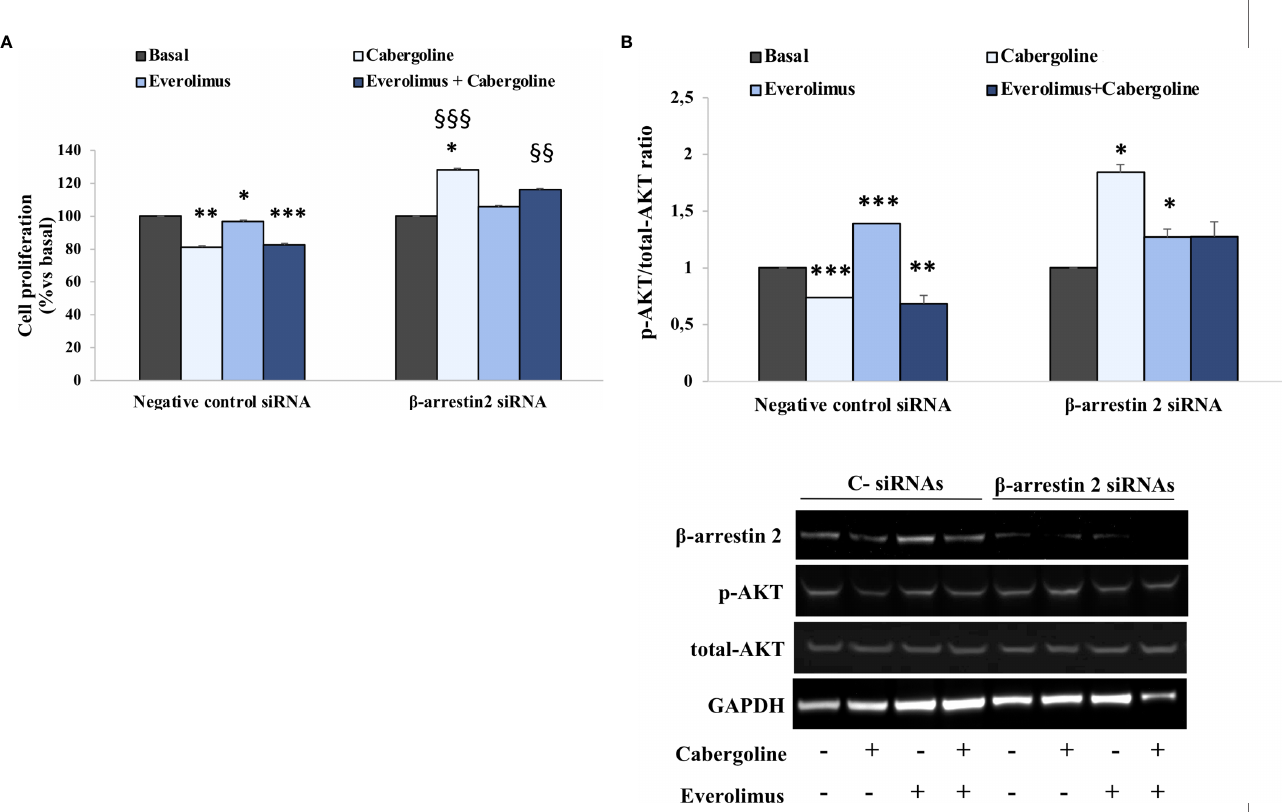
FIGURE 3 | b -arrestin 2 lack reverted everolimus and cabergoline cotreatment ability in reducing both p-AKT and cell proliferation in MMQ cells. The MMQ cells were transiently transfected with b -arrestin 2 siRNAs or negative control siRNAs (C-) for 72 h and then incubated with 100 nM cabergoline and 1 nM everolimus for 72 h (A) or 3 h (B) , administered singularly or in combination. (A) BrdU incorporation in newly synthesized DNA was measured. The experiments were repeated 4 times, and each determination was done in quadruplicate. Values represent mean ± SD normalized vs. respective basal. * p < 0.05, *** p < 0.001 vs. corresponding basal, §§ p < 0.01; §§§ p < 0.001 vs. corresponding treated negative control. (B) Densitometrical analysis of p-AKT (Ser473)/total AKT ratio normalized vs. respective basal (mean±SD from 3 independent experiments), and representative immunoblots are shown. The equal amount of proteins was con fi rmed by stripping and reprobing with an anti-GAPDH antibody. * p < 0.05, ** p < 0.01, *** p < 0.001 vs. corresponding